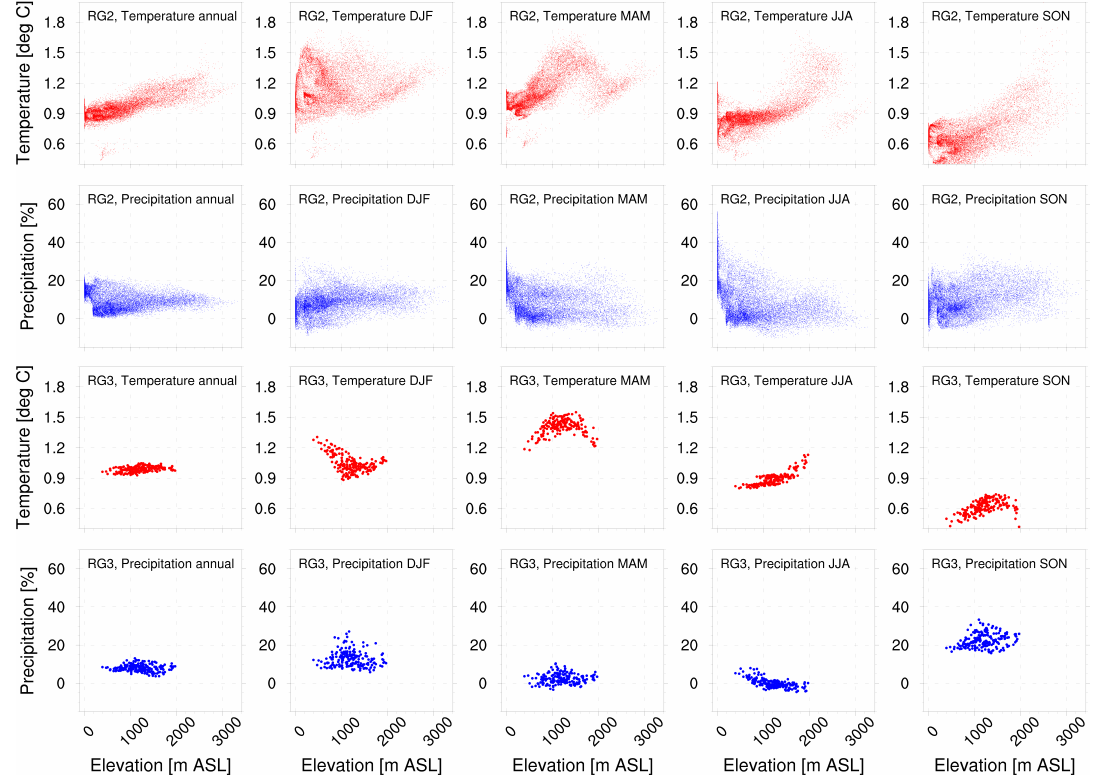
Figure 19. Annual and seasonal elevation-dependency of projected changes (2020–2049 compared to 1980–2009) in temperature and precipitation for RG1 (first and second row), RG2 (third and fourth row), and RG3 (fifth and last